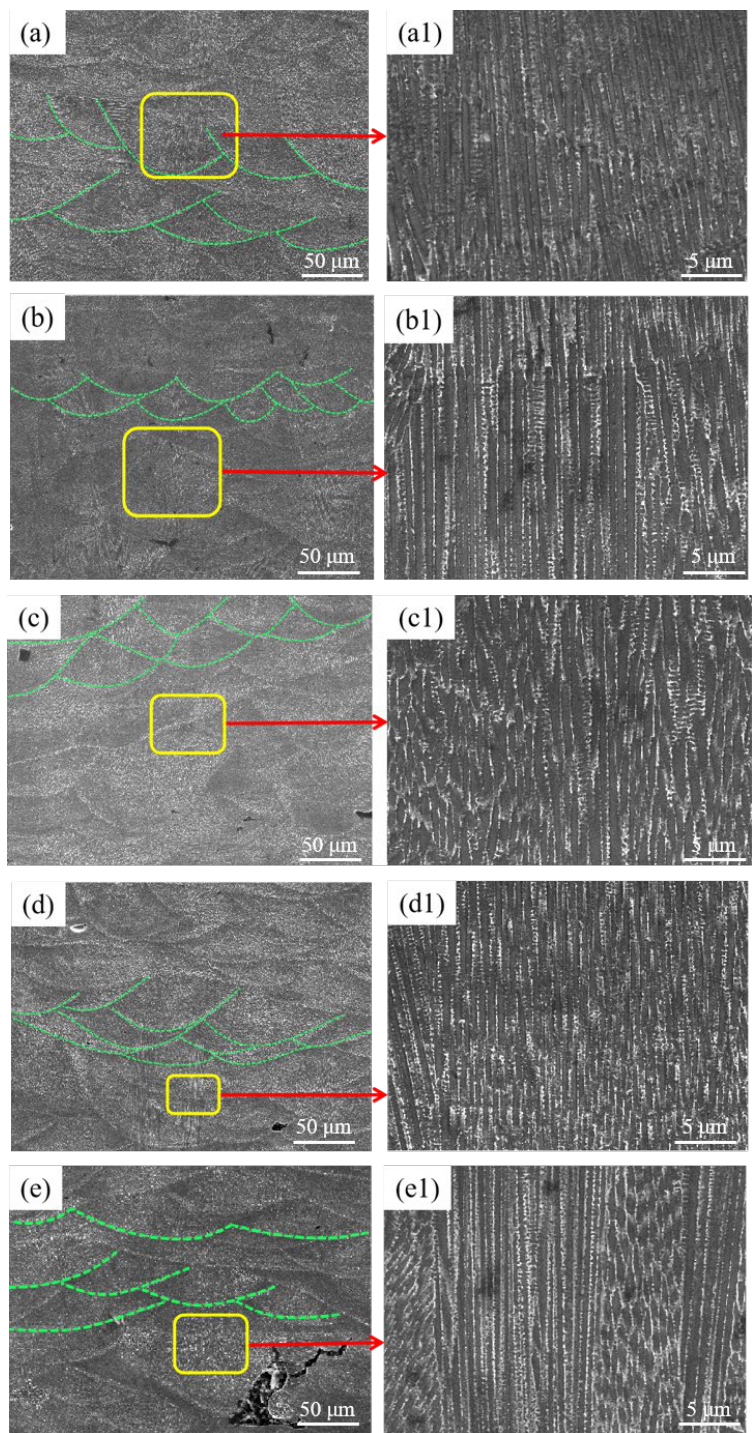
Figure 4. SEM image of the corresponding K418 sample under different scanning speeds: ( a , a1 ) 800 mm/s; ( b , b1 ) 1000 mm/s; ( c , c1 ) 1200 mm/s; ( d , d1 ) 1400 mm/s; ( e , e1 ) 1600 mm/s.